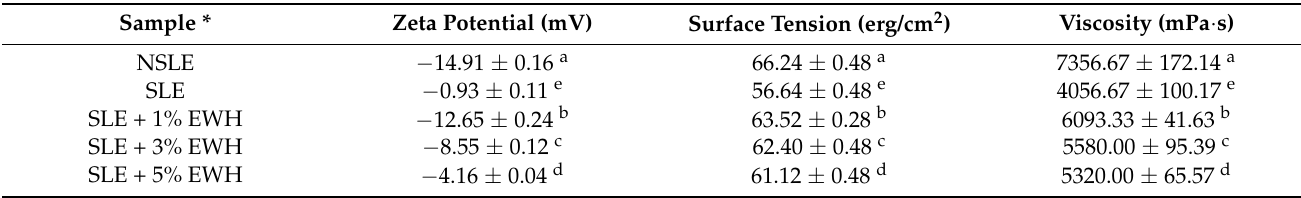
Table 1. Zeta potential, surface tension, and viscosity of non-sterilized liquid egg white (NSLE), sterilized liquid egg white (SLE), and SLE supplemented with 1%, 3%, or 5% egg white hydrolysate (EWH). Sample * Zeta Potential